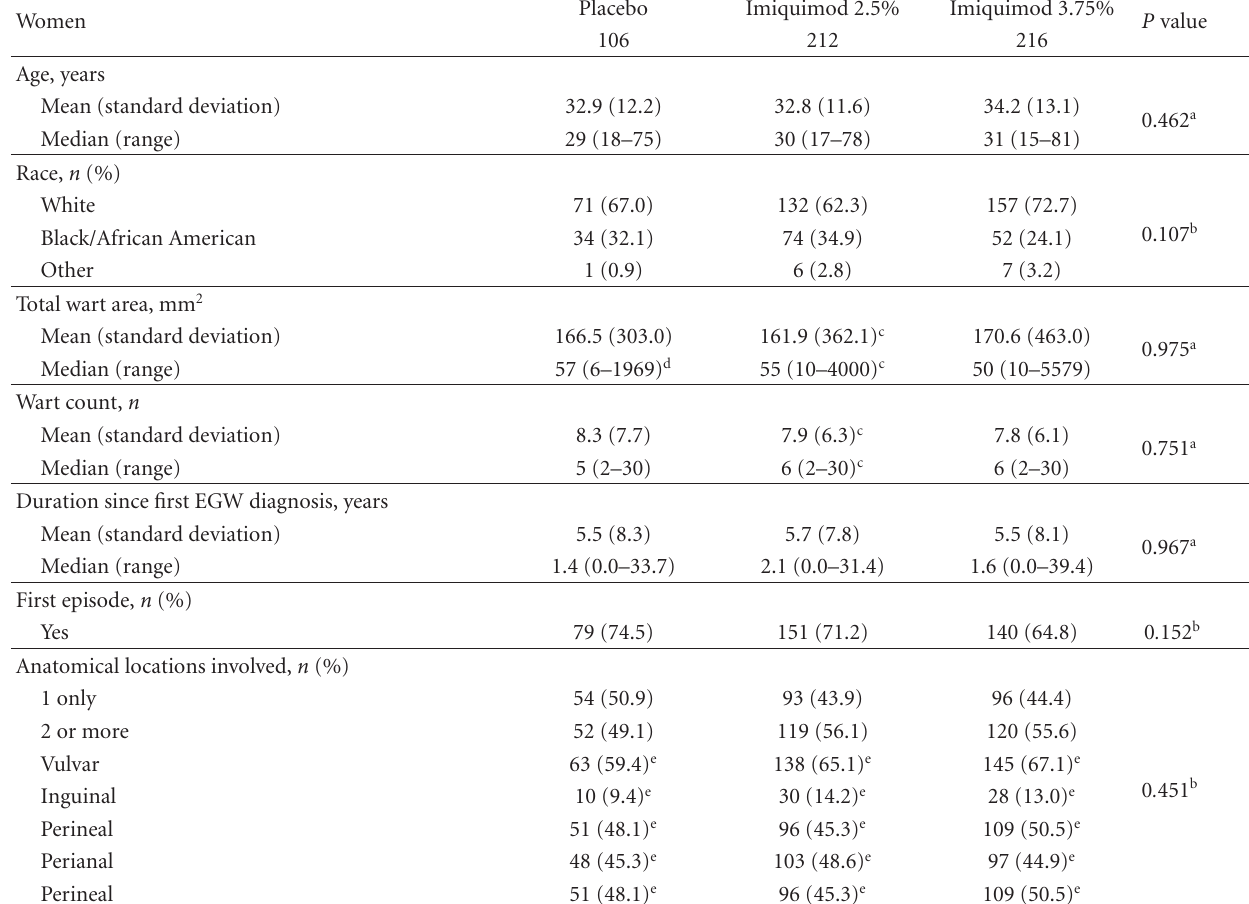
Table 1: Demographic and external anogenital wart characteristics by treatment group, all